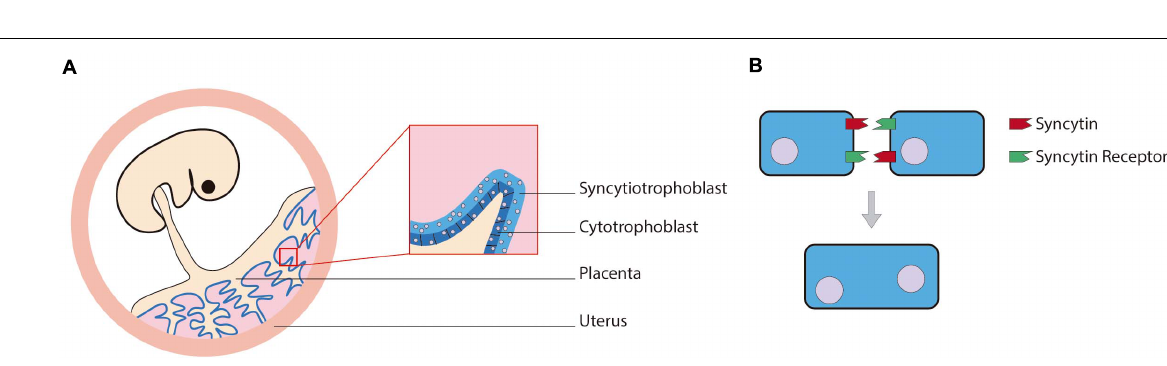
Frontiers in Cell and Developmental Biology |